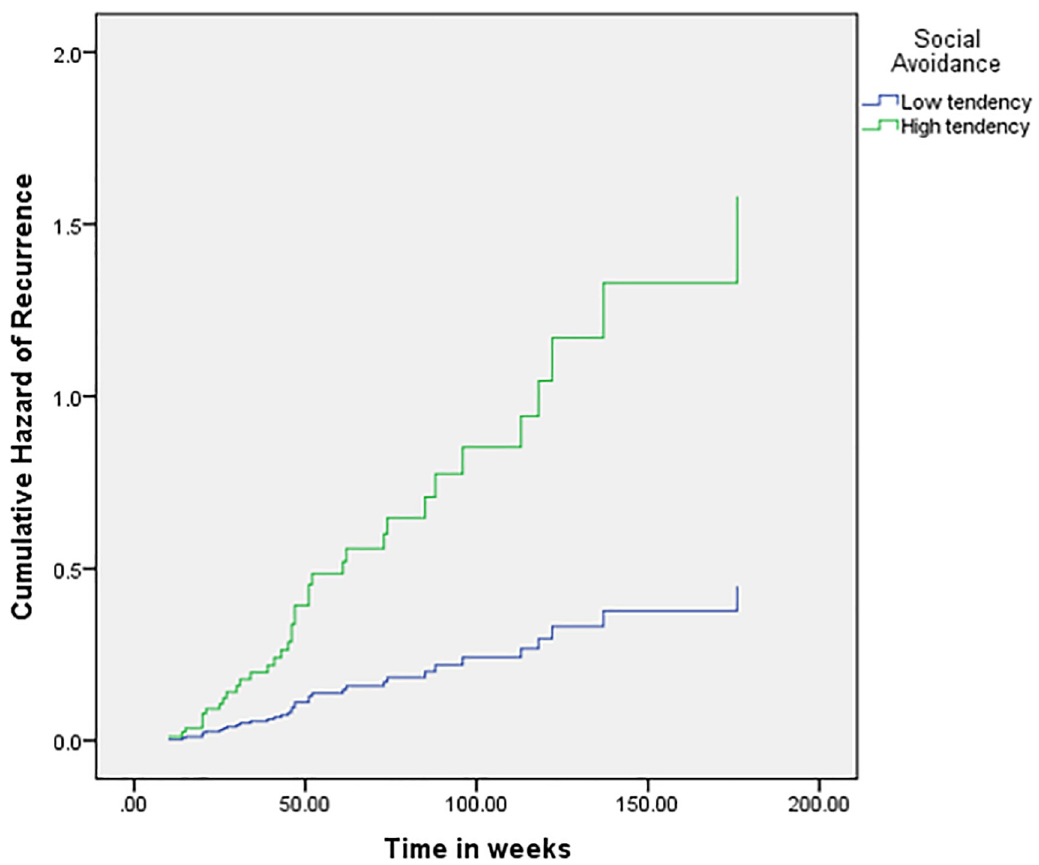
Fig 2. Hazard function for recurrence of MDD by social avoidance.